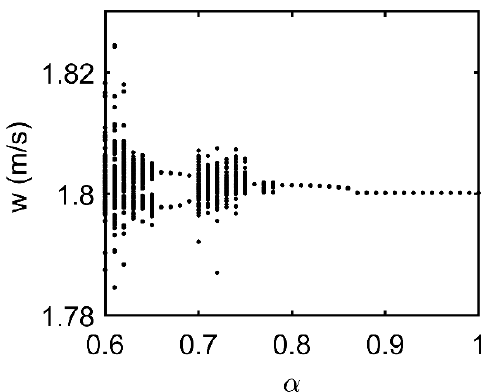
Figure 6. Bifurcation diagram of the FOM respecting to fractional-order α (V = 84.5). When reducing the fractional-order, a small chaotic motion starts to occur at α = 0.78, but disappears at α = 0.76 and reoccurs at α = 0.75 with bigger magnitudes. At α = 0.69, there is a sudden transformation from chaotic motion to a period-doubling